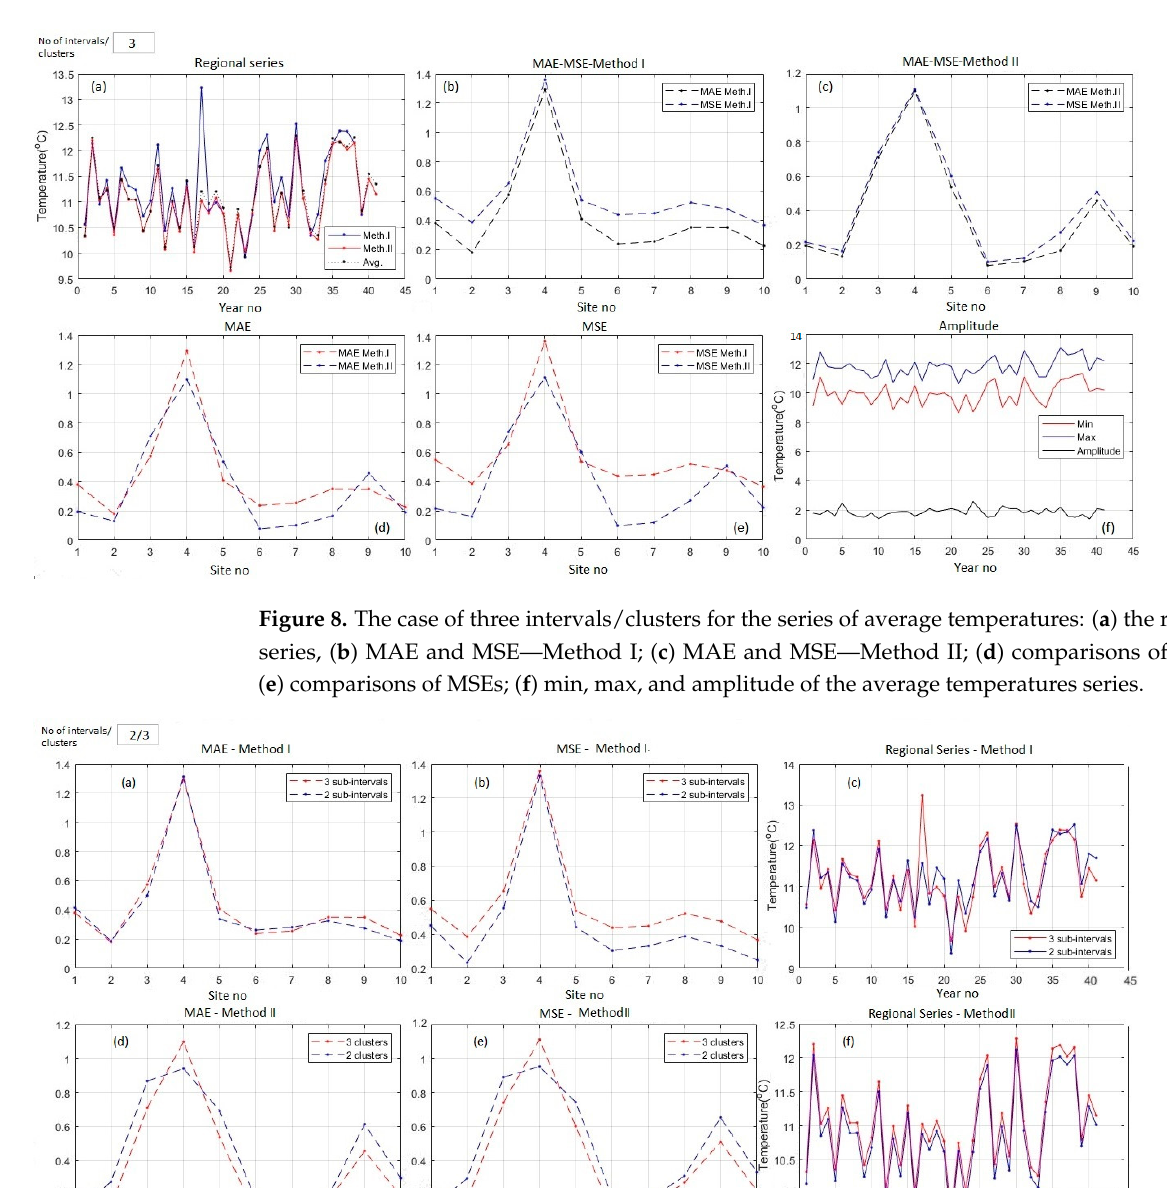
Figure 7. The case of two intervals/clusters for the series of average temperatures: ( a ) the regional series, ( b ) MAE and MSE—Method I; ( c ) MAE and MSE—Method II; ( d ) comparisons of MAEs; ( e ) comparisons of MSEs; ( f ) min, max, and amplitude of the average temperatures series.